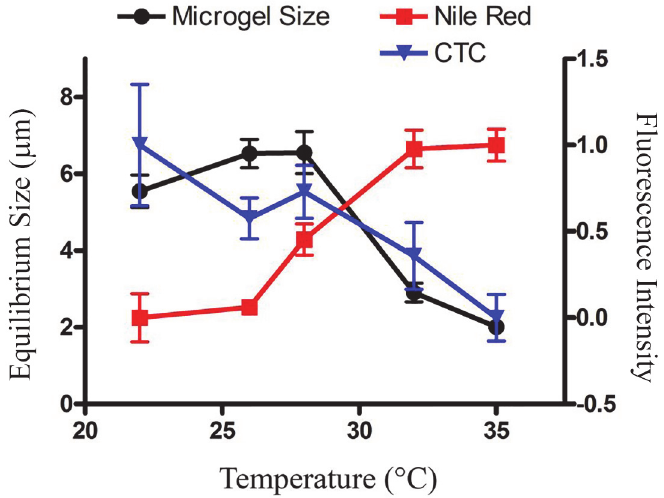
Fig 4. Decreased microgel equilibrium size (black circles) and bound Ca 2+ (blue triangles) with concomitant increase in hydrophobicity (red squares). The non-linear rate of declining microgel size with increased temperature indicates potential cooperativity; around 32 ˚ C all three parameters experienced the most pronounced associative effect — a major drop in microgel size and bound Ca 2+ , with a concomitant rise in